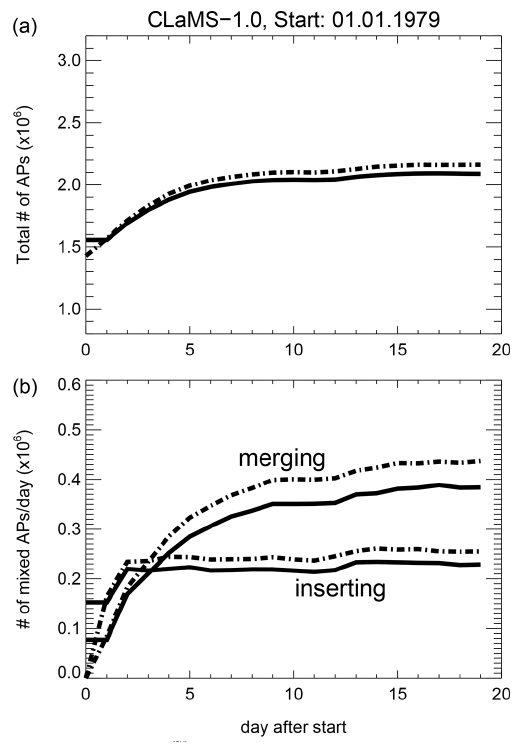
Figure A2. Starting with the initial distribution of APs (1 Jan- uary 1979, baseline run), their total number increases in the CLaMS 1.0 standard configuration during the first 2 weeks of the simulation for both EI (solid) and E5 (dashed) cases (a) . Panel (b) shows the numbers of APs after mixing step due to insertion (lower branch) and due to merging (upper branch). A steady state is reached after about 10d. Note that the number of merged APs is always larger than the number of inserted APs. This is because a large part of inserted APs is subsequently merged, and consequently counted as merged and not as inserted.